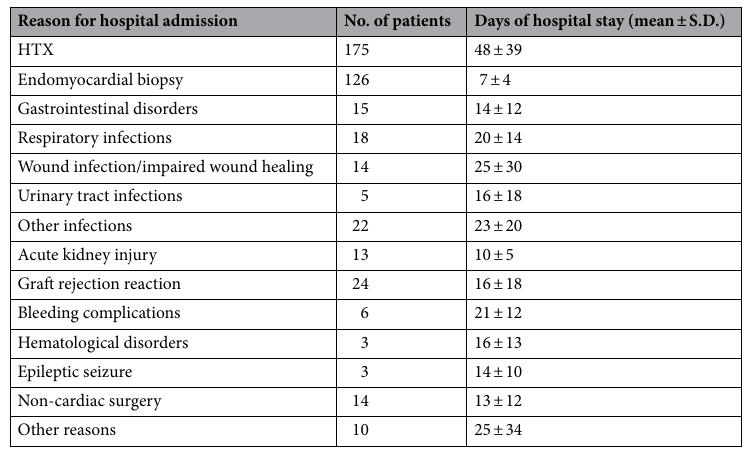
Table 2. Reasons for hospital admission and corresponding mean days of hospital stay. HTX Heart transplantation.